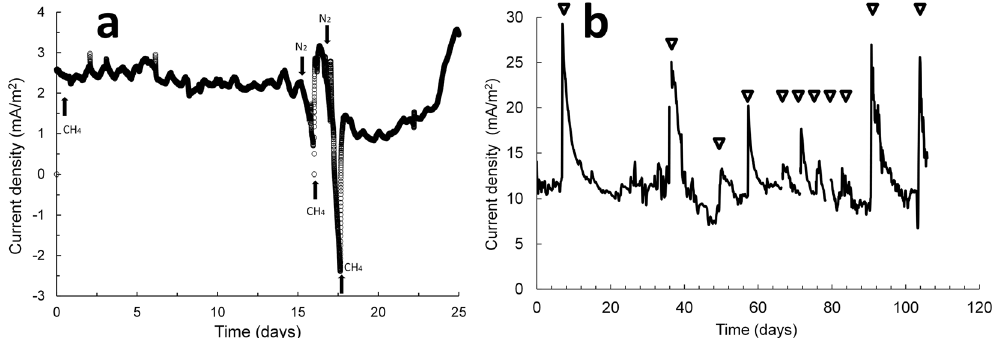
Figure 1. Current generation from anaerobic oxidation of methane in a microbial electrochemical cell (MxC). Methane was the sole electron donor, and no exogenous electron acceptor was provided except for the carbon fiber electrodes. ( a ) Current density in response to alternate methane and nitrogen gas. This alternating gas test was conducted with the MxC in the acclimation period. ( b ) Current density over time in the MxC operated inside the anaerobic chamber (MxC AC ). Connection and disconnection of the electrodes during the supply of methane caused abrupt increases in current density due to biofilm capacitance effects 42 . Triangles indicate the points of